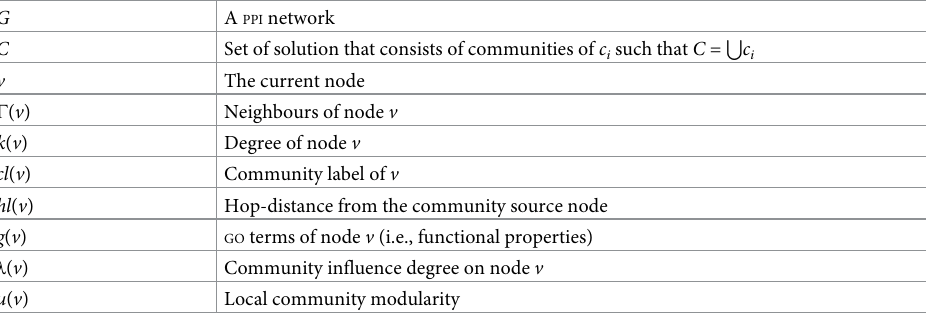
Table 1. Notation exploited in LCDA - GO